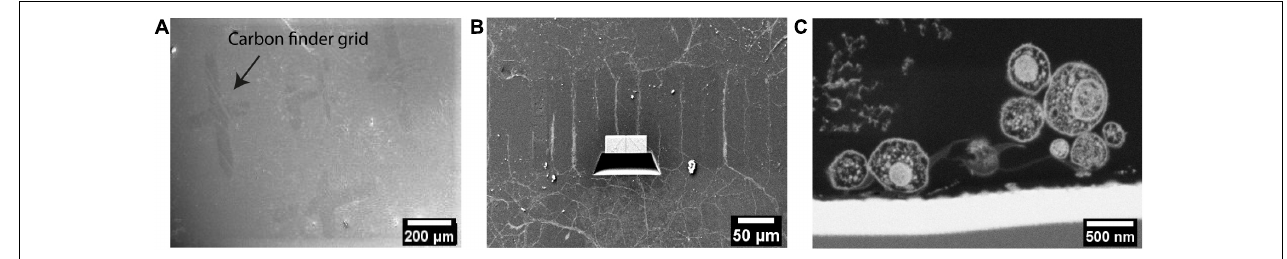
FIGURE 5 | Ultrastructural analysis of resin-embedded embryonic striatal neurons by FIB-SEM. (A) SEM images of the surface of resin block. The carbon finder grid was transferred to the resin block and it was clearly detectable by SEM. (B) The neurites in the channels were targeted and processed by FIB-SEM. (C) Cross-section of neurites in a channel laid open by FIB and imaged by